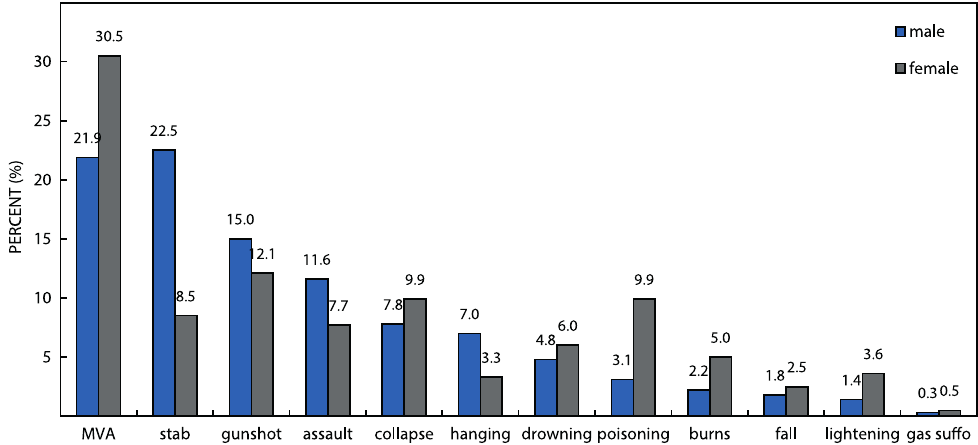
Figure 4: Percentages of males vs. females cause of death in the Transkei region of South Africa from 1996 to 2015 ( n = 24